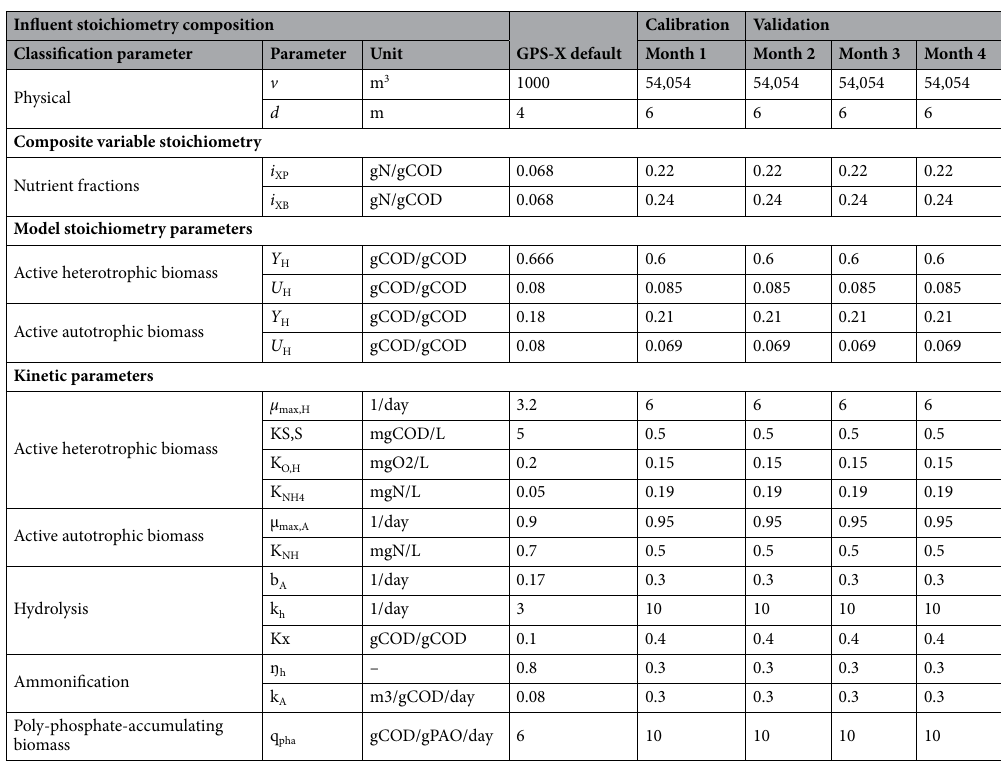
Table 7. Aeration basin GPS-X default and adjusted models stoichiometry and kinetic parameters.